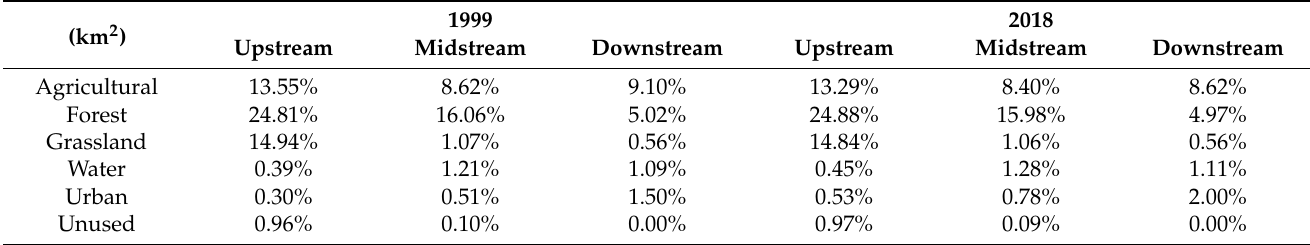
Table 1. The proportion of land use in the upstream, midstream, and downstream in the